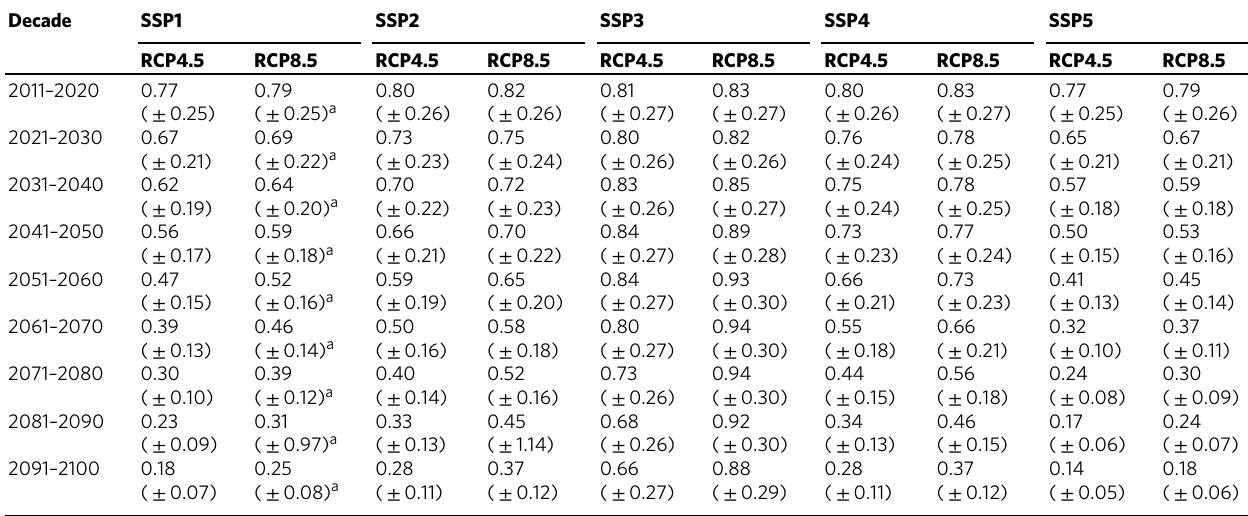
Table 1 Projected mean estimates ( ± uncertainty) of premature mortality burden per year (in million) in India due to ambient PM 2.5 exposure till the end of the century for the 10 combined RCP – SSP scenarios